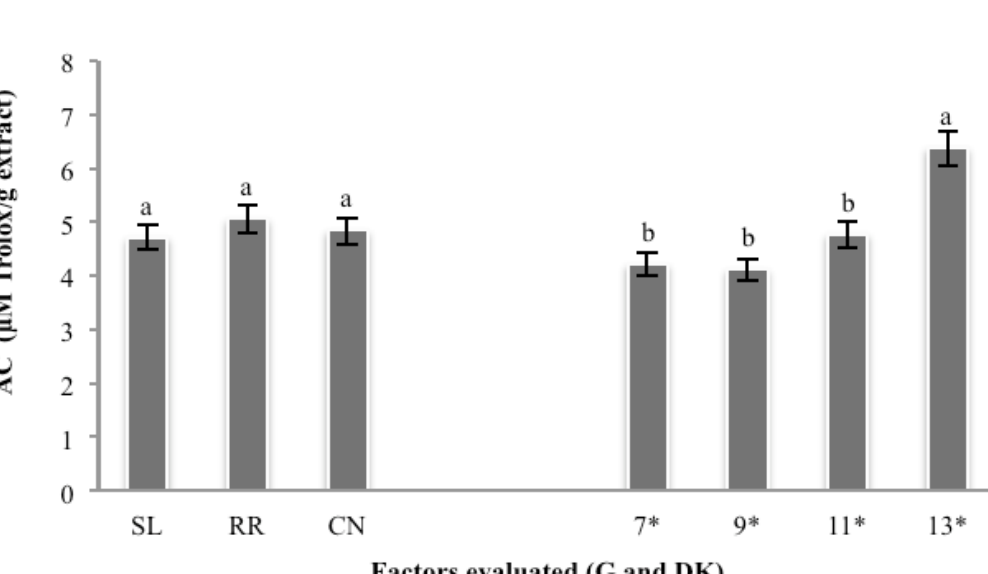
Figure 3. Effects caused by Genotype (G) and K + dose (DK) on the Antioxidant Capacity (AC) of hydroponic basil. Different letter between column and factor indicated significant differences according to Tukey test ( p ≤ 0.05). SL: “Sweet Lemon”; RR: “Red Rubin”; CN: “Cinnamon”; *: mmol·L −1 . Interval bars are the standard error.